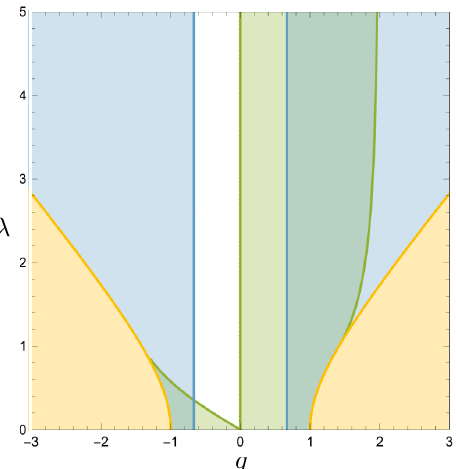
Figure 1 . Conditions on λ and q necessary for the existence of a horizon in the string-frame metric given in eq. (2.15). We have that g tt ∝ f ( r ) and g rr ∝ g ( r ) vanish in the r → r + limit in the regions shaded green and blue, respectively. The yellow region is forbidden by eq. (2.17), which enforces q 2 ≤ 1 + λ 2 for reality of the